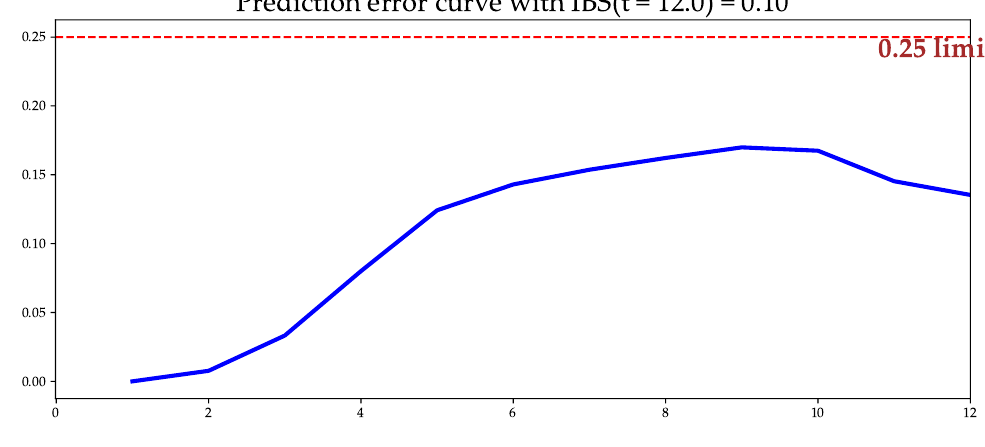
Figure 10. Model performance for cluster 8. Table 4. Feature importance in the survival model with cluster 0.